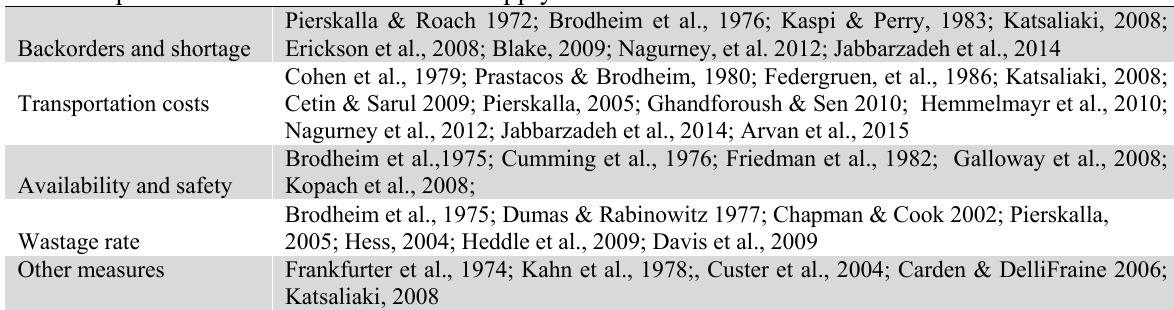
Table 1 Different performance measures in blood supply chain Pierskalla & Roach 1972; Brodheim et al., 1976; Kaspi & Perry, 1983; Katsaliaki, 2008; Backorders and shortage Erickson et al., 2008; Blake, 2009; Nagurney, et al. 2012; Jabbarzadeh et al., 2014 Cohen et al., 1979; Prastacos & Brodheim, 1980; Federgruen, et al., 1986; Katsaliaki, 2008; Transportation costs Cetin & Sarul 2009; Pierskalla, 2005; Ghandforoush & Sen 2010; Hemmelmayr et al., 2010; Nagurney et al., 2012; Jabbarzadeh et al., 2014; Arvan et al., 2015 Brodheim et al.,1975; Cumming et al., 1976; Friedman et al., 1982; Galloway et al., 2008; Availability and safety Kopach et al., 2008; Brodheim et al., 1975; Dumas & Rabinowitz 1977; Chapman & Cook 2002; Pierskalla, Wastage rate 2005; Hess, 2004; Heddle et al., 2009; Davis et al., 2009 Other measures Frankfurter et al., 1974; Kahn et al., 1978;, Custer et al., 2004; Carden & DelliFraine 2006; Katsaliaki,